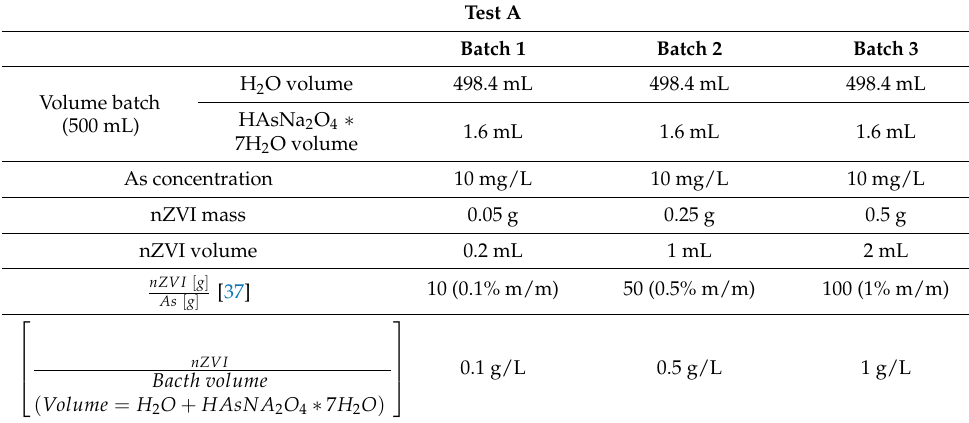
Table 2. Batch compositions (Test A).